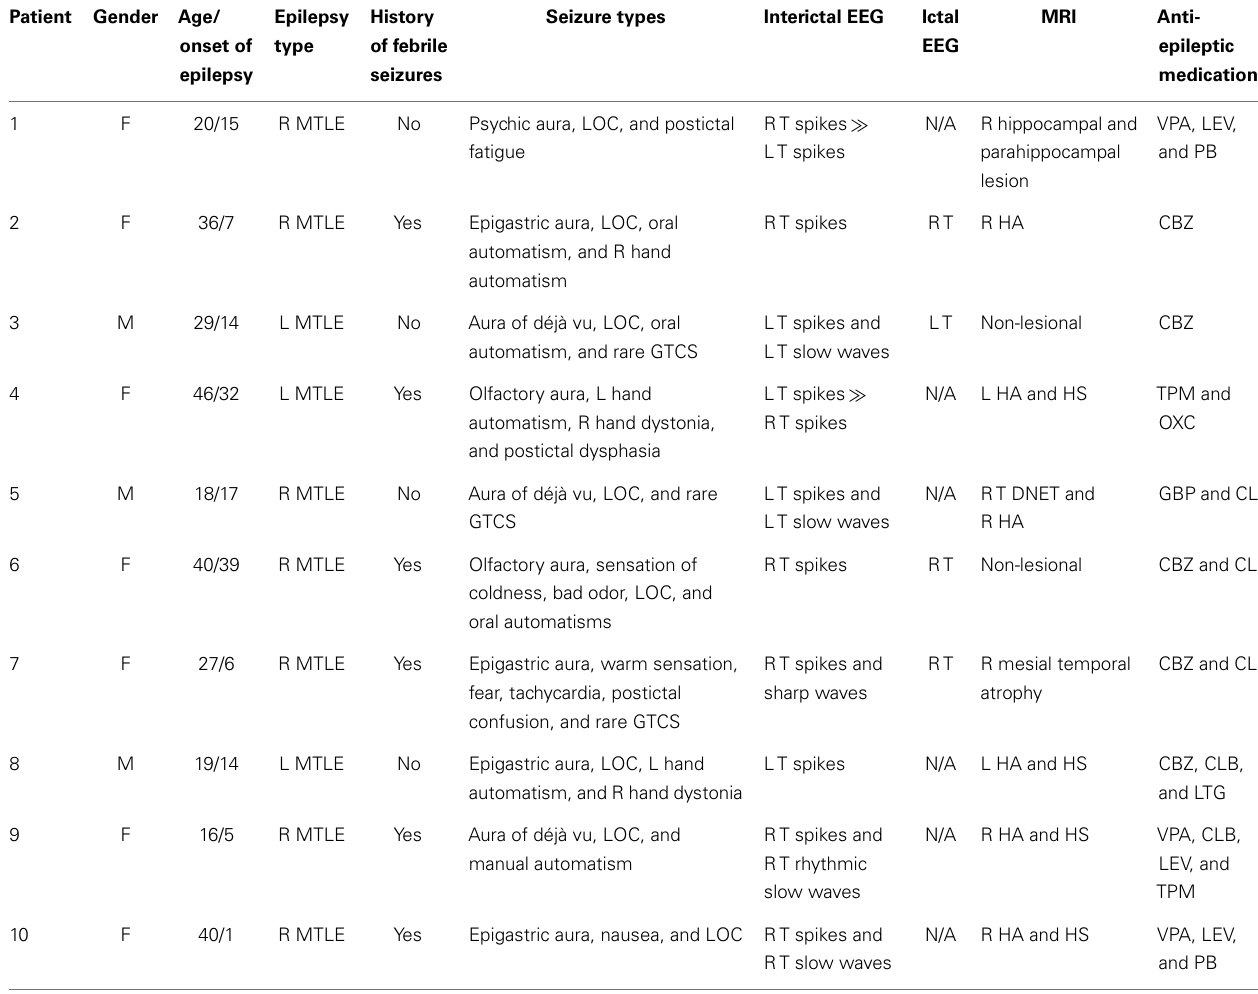
Table 1 | Patients’ clinical data